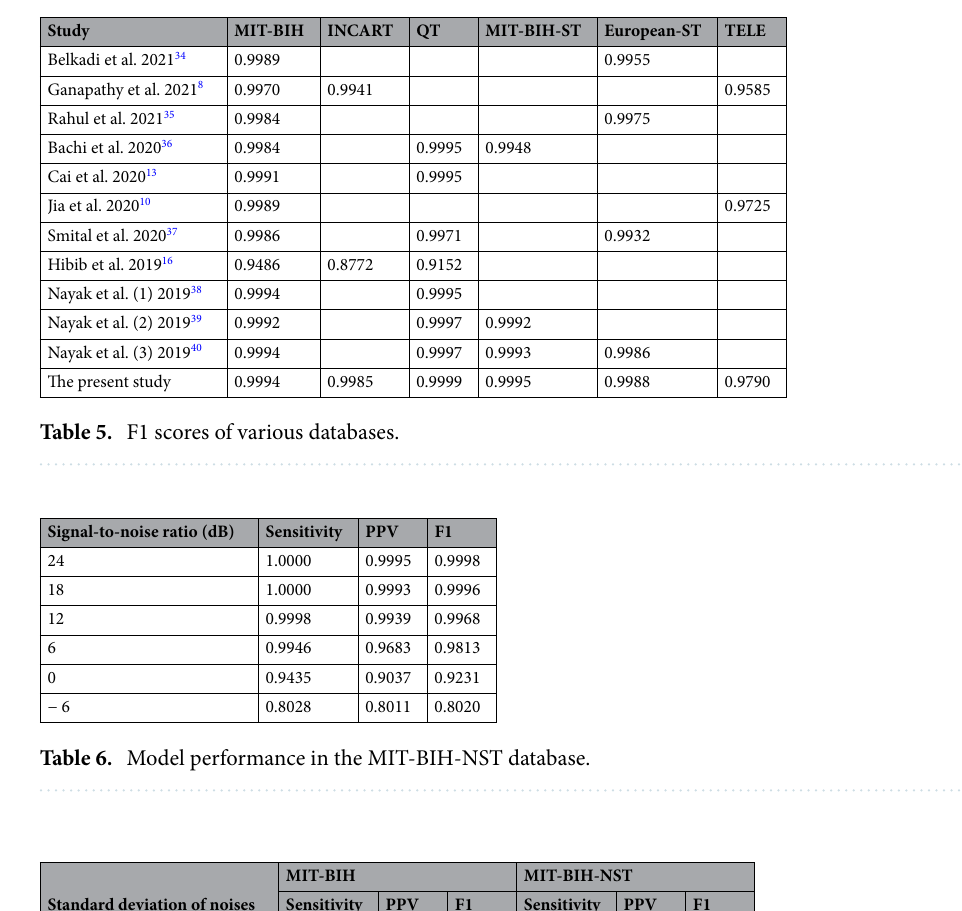
Standard deviation of